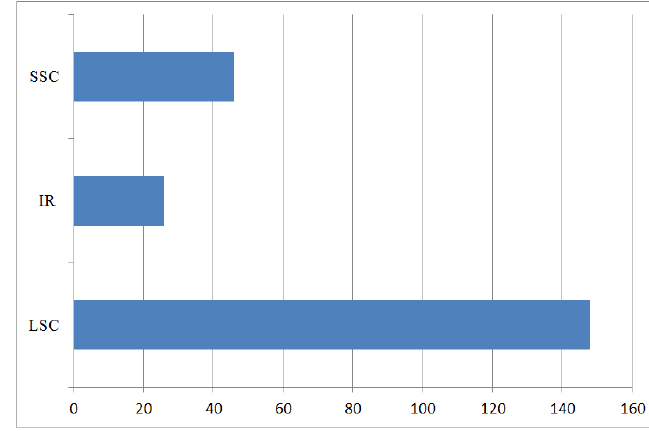
Figure 5. Simple sequence repeats (SSRs) distribution in three different regions: LSC, SSC and IR region. X-axis represents the number of SSRs.